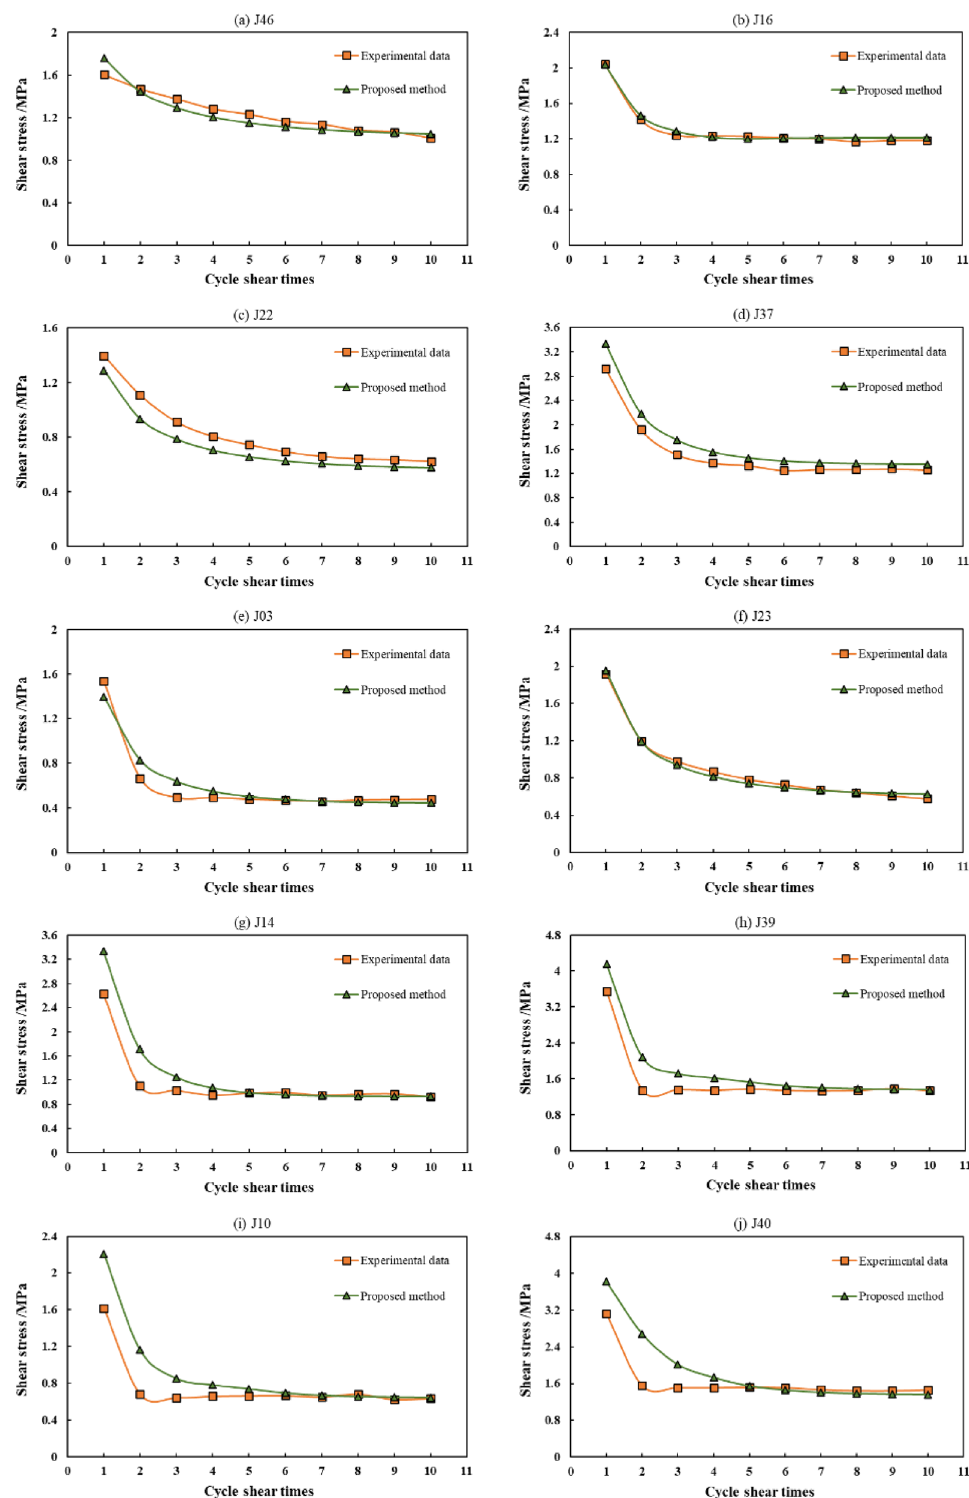
Figure 7. Comparison between the calculated results and the experimental